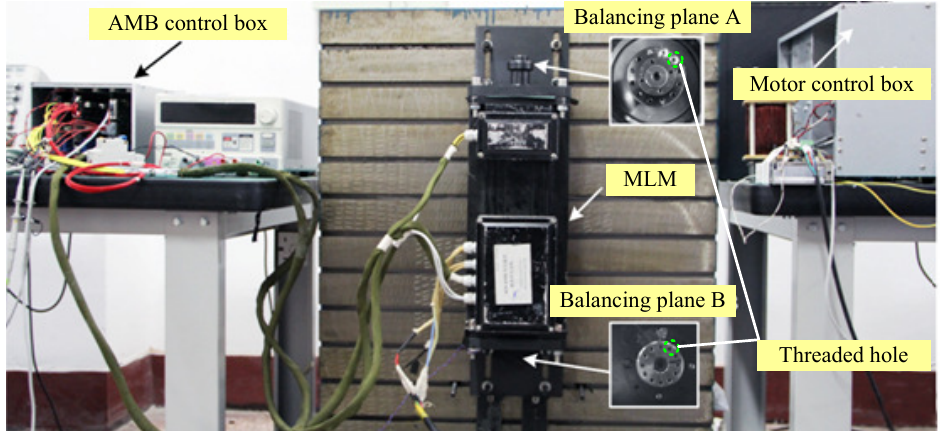
Figure 16. Photograph of the 4 kW MLM, AMB control box and motor control